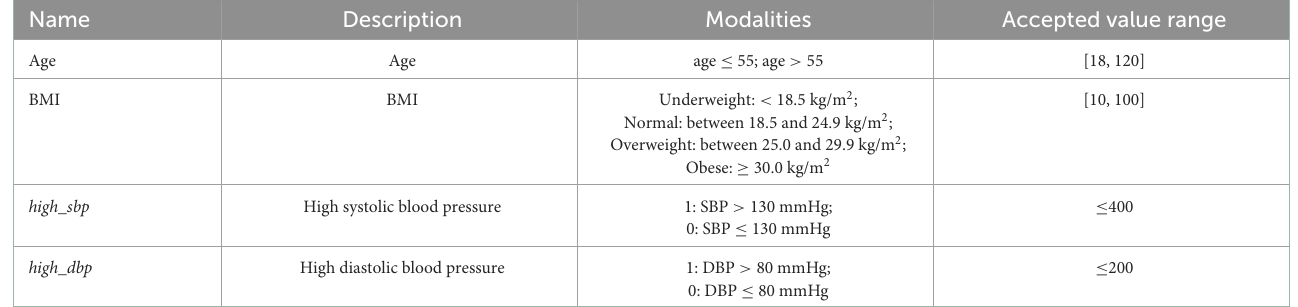
TABLE 2 Description of quantitative feature